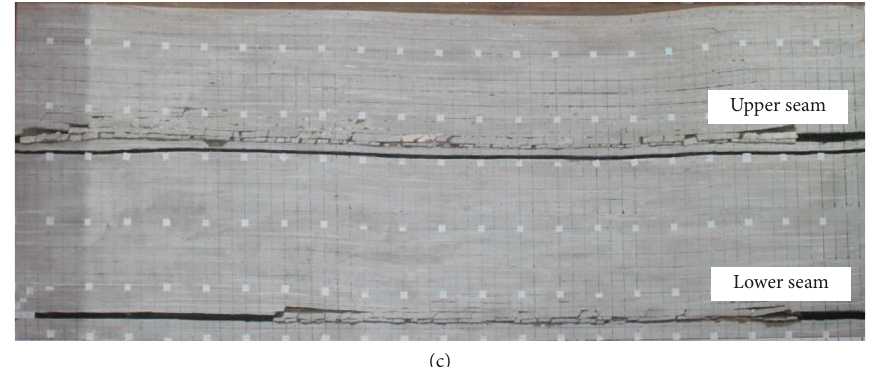
Figure 5: Physical modelling results after extraction of (a) lower and (b) upper panels in Case 2 and (c) extension part in Case